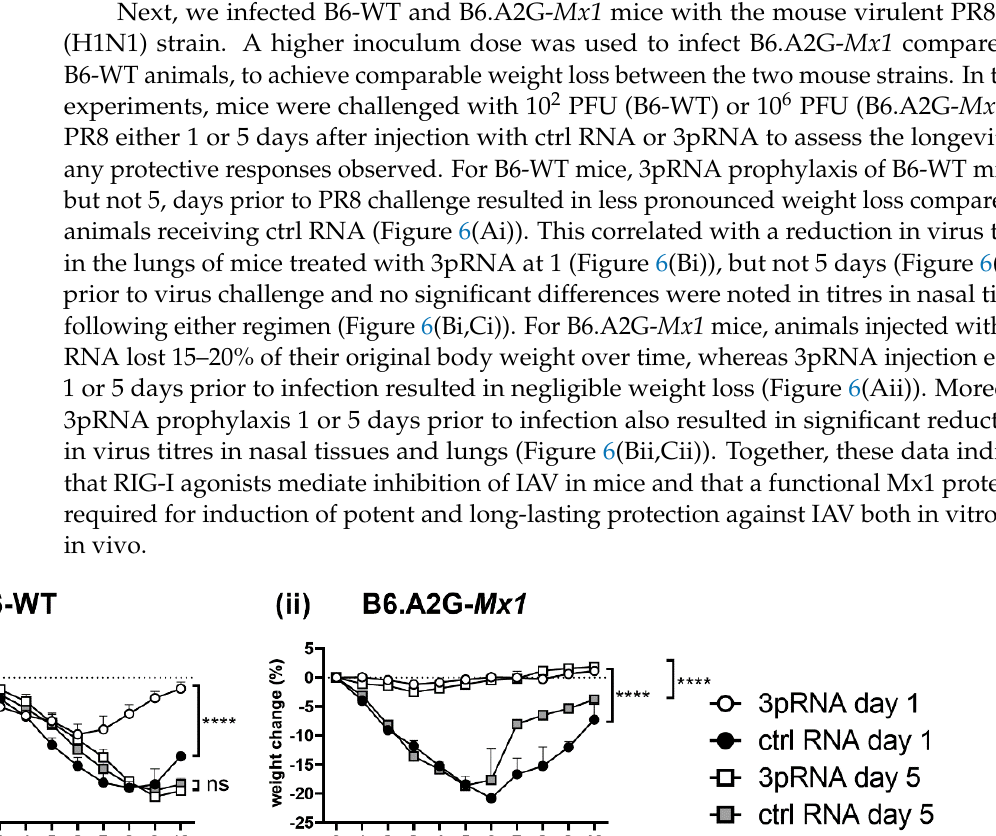
Figure 6. After a single intravenous injection of mice with RIG-I agonist, expression of a functional Mx1 protein is critical for potent and long-lasting protection from subsequent IAV challenge. B6- WT and B6.A2G- Mx1 mice received a single i.v. injection of 12.5 μ g RIG I agonist (3pRNA) or control RNA (ctrl RNA). At either 1 or 5 days after treatment mice were infected by the i.n. route with 10 2 PFU (B6-WT) or 10 6 PFU (B6.A2G- Mx1 ) of IAV strain PR8 (H1N1) in 50 μ L of PBS. ( A ) Mice were monitored daily, and data shows the mean percent (± SEM) of weight change over time determined relative to original body weight. ( B , C ) Nasal tissues and lungs were harvested 5 days after infection, homogenized and virus titres in clarified homogenates were determined by plaque assay on MDCK cells. Data are expressed as mean ± SD ( n = 4–5/group). Dashed lines represent the limit of detection of the plaque assay. Samples below the detection limit (<1.8 log 10 PFU/mL) were assigned a value of 1.7 log 10 PFU/mL for statistical analysis. ( A ) Student’s t -test was performed to compare weight loss after 3pRNA or ctrl RNA treatment. ( B , C ) Two-way ANOVA with Bonferroni’s multiple compari- son test was performed to compare weight loss and viral titres after 3pRNA or ctrl RNA treatment. ** = p < 0.01; *** = p < 0.001; **** = p < 0.0001; ns = not significant. 4. Discussion To date, most in vivo studies evaluating the antiviral function of RIG-I agonists against IAV have been performed using laboratory mouse strains such as C57BL/6 and BALB/c which do not express a functional Mx1, an ISG protein known to mediate potent anti-IAV activity [33]. These studies report that prophylactic i.v. administration of RIG-I agonists 24 h prior to infection combined with a second dose on the day of infection [8,9], or alternatively, combined with three subsequent doses post infection [10], can provide some protection from subsequent challenge with different IAV, including H5N1 strains. In general terms, these RIG-I agonist treatment regimens improved overall survival rates, although only modest differences in IAV-induced weight loss were noted when compared